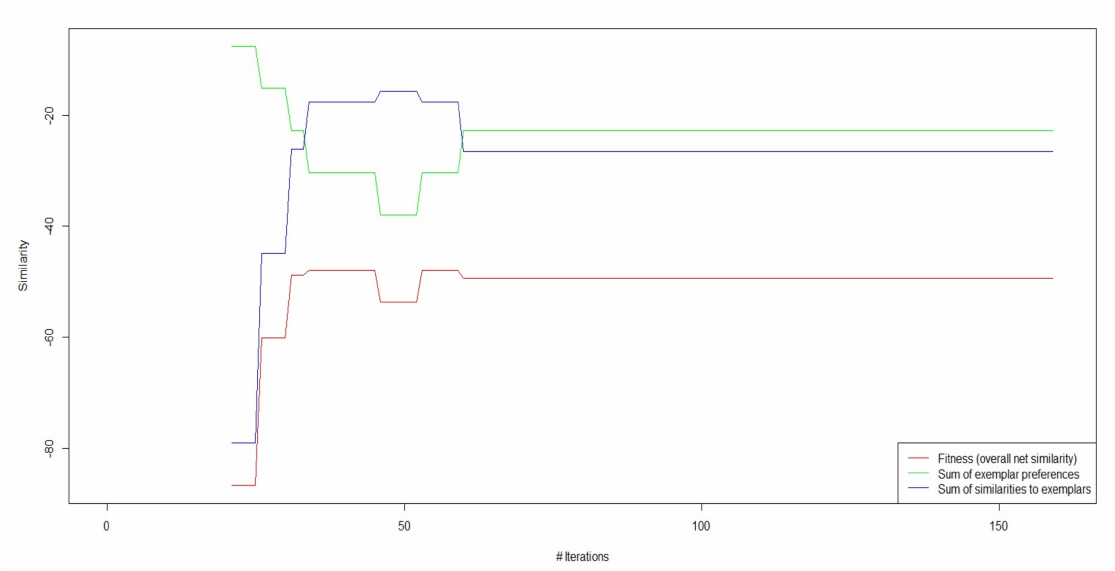
Figure 1. Similarity convergence for: (green) sum of exemplar preferences; (purple) sum of similarities to exemplars; and (red)